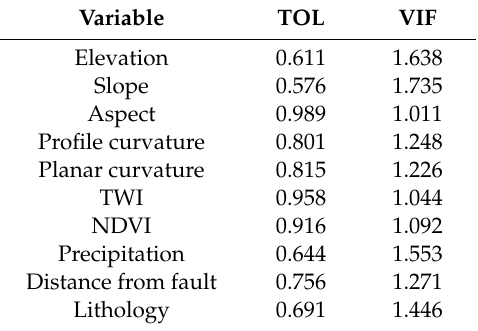
Table 1. Multicollinearity diagnostics for the variables used in this